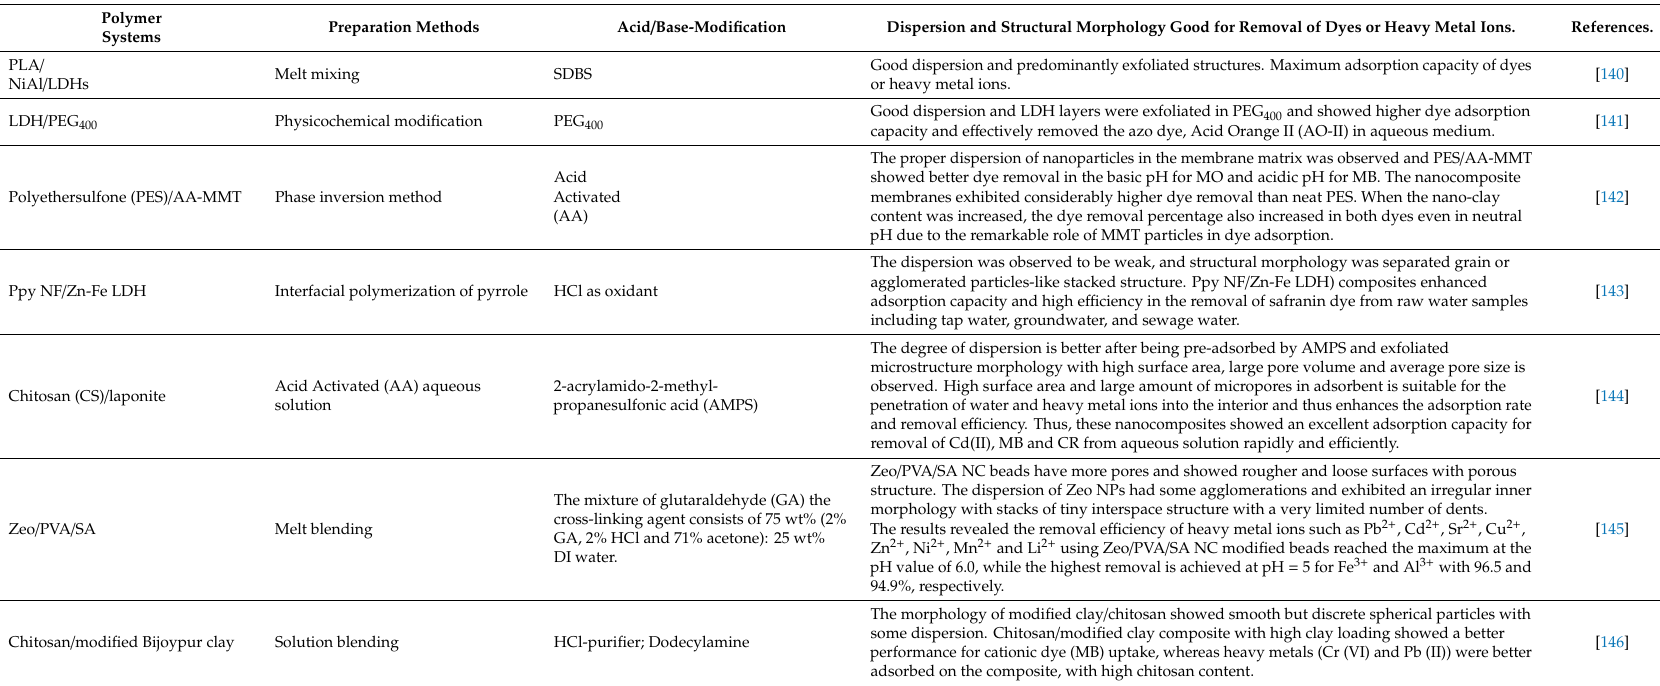
Table 4. Summary of selective studies on acid / base-modification of polymer / clay and LDH nanocomposites for water